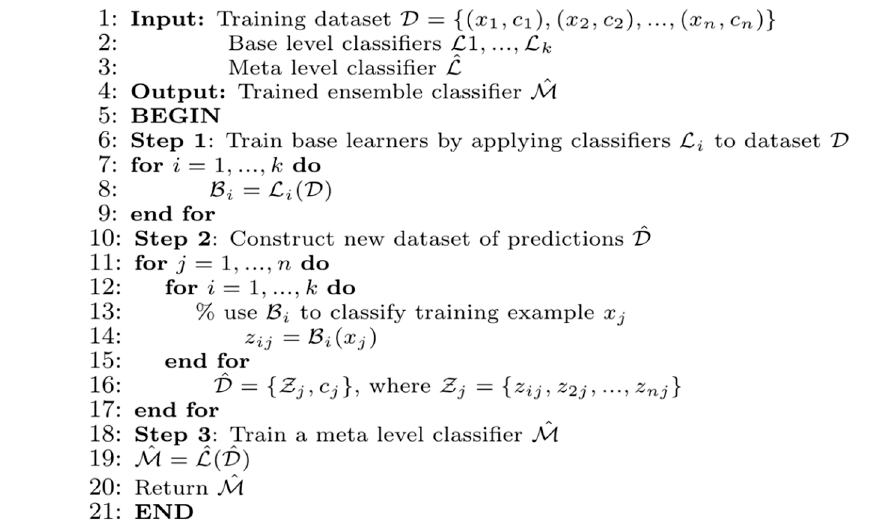
Algorithm 1. Pseudocode of the ensemble learning algorithm.